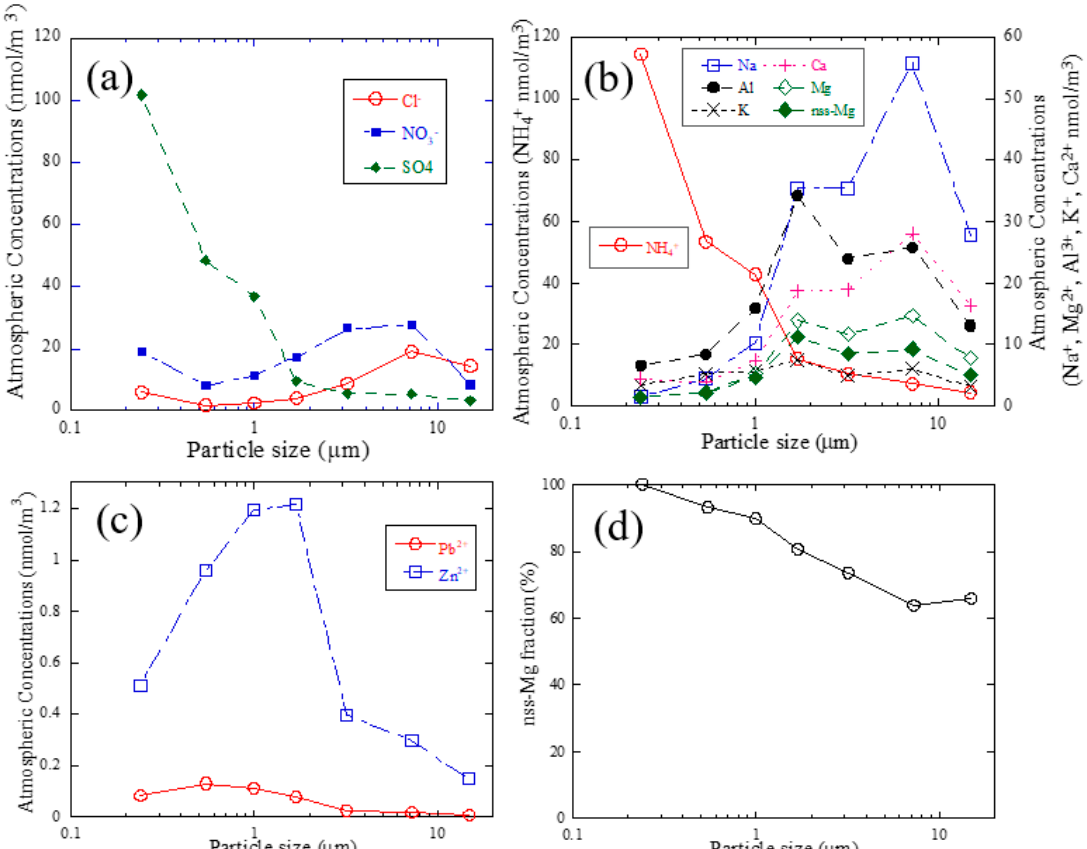
Figure 2. Atmospheric concentrations of ( a ) major anions (water extraction), ( b ) major cations (acid digestion), ( c ) trace elements (Zn and Pb; acid digestion), and ( d ) the ratio of nss-Mg to total Mg.